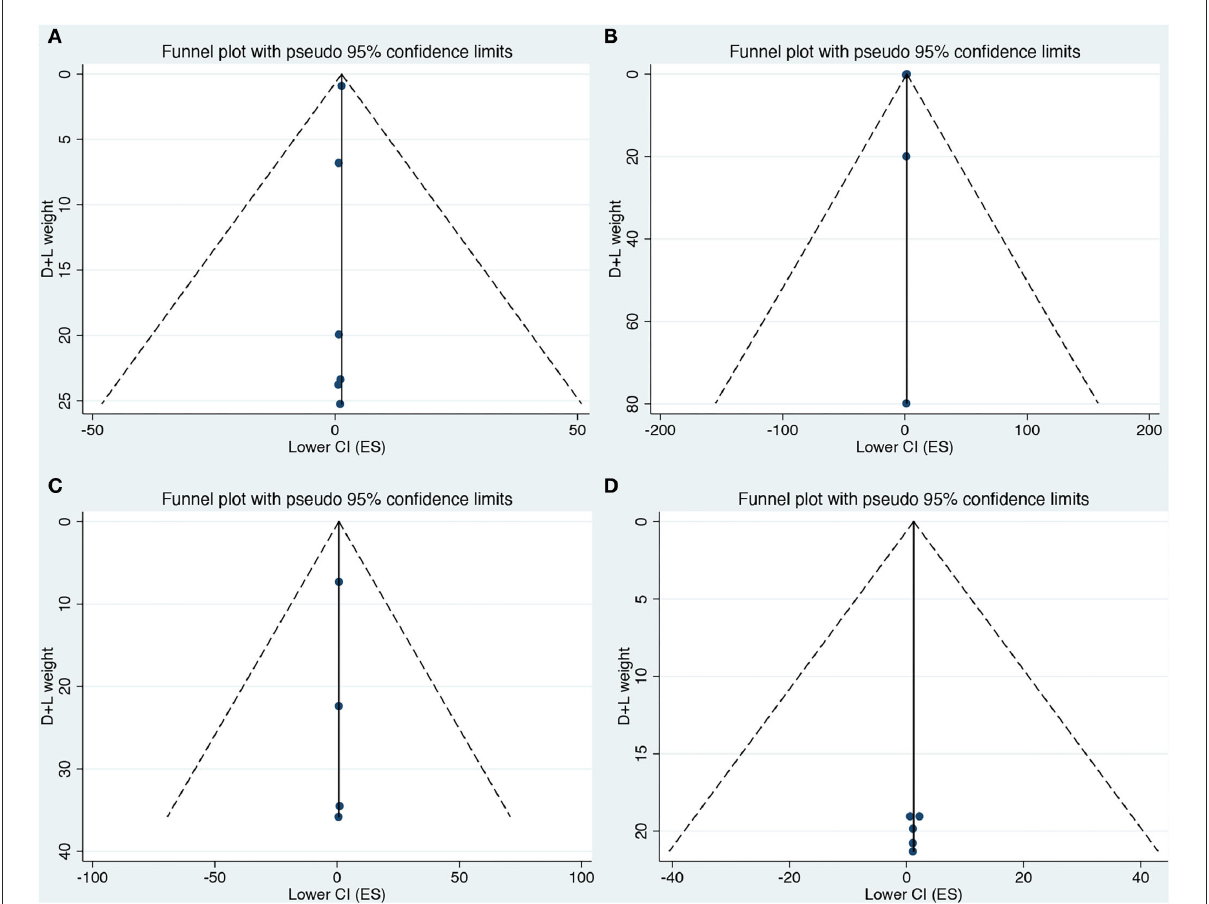
FIGURE3 (A–D) Funnel plot for the association of prenatal exposure to antibiotics and risk of neurodevelopmental disorders in the offspring. (A) Risk of ASD. (B) Risk of ADHD. (C) Risk of CP. (D) Risk of